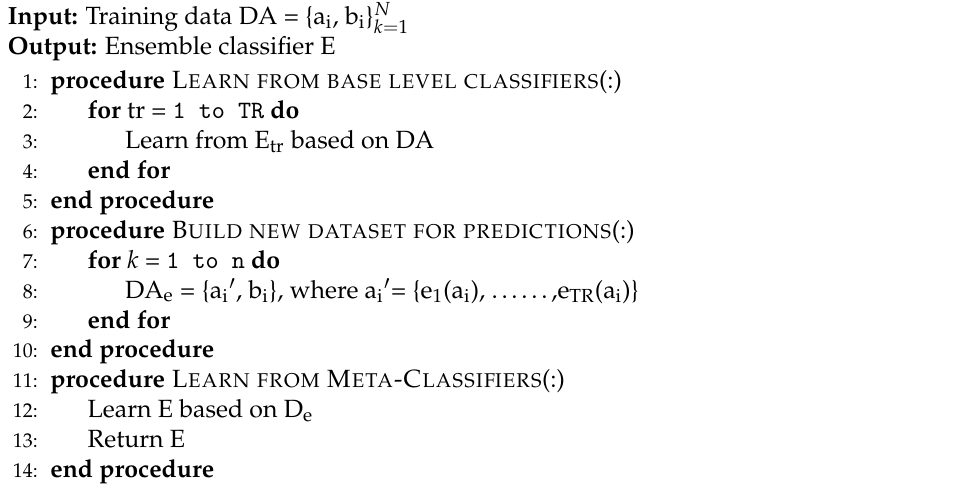
Algorithm 1 Meta learning from base-level classifiers and the final ensemble classifier for prediction